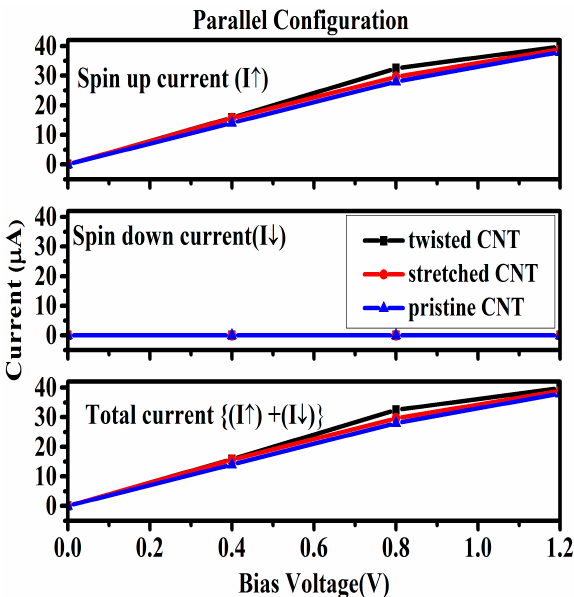
Figure 4. Comparison of current-voltage curves in PC for all three structures. The total spin current of twisted CNT is greater than that of stretched CNT, and the total spin current of stretched CNT is greater than that of pristine CNT.